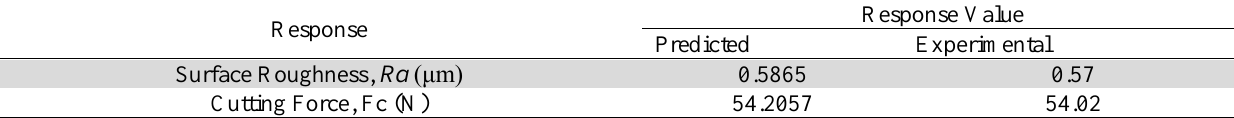
Result of Confirmation